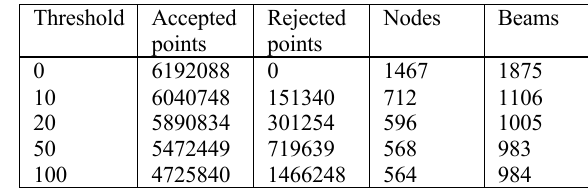
Table 8b. Effects of different threshold values on the 10 cm